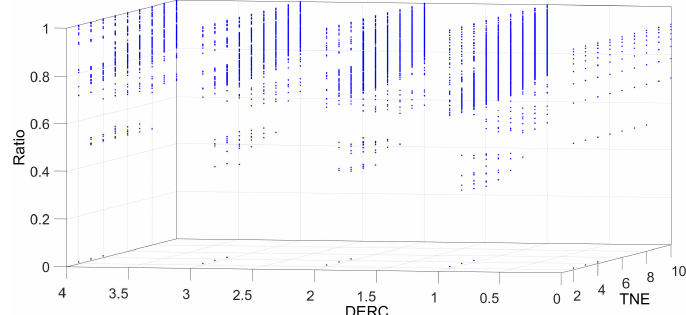
Figure 10. Relationship between the potential level (DPA) and the threshold (TPA) in Alayer . Only in case of low DPA or TPA values, the number of output events is